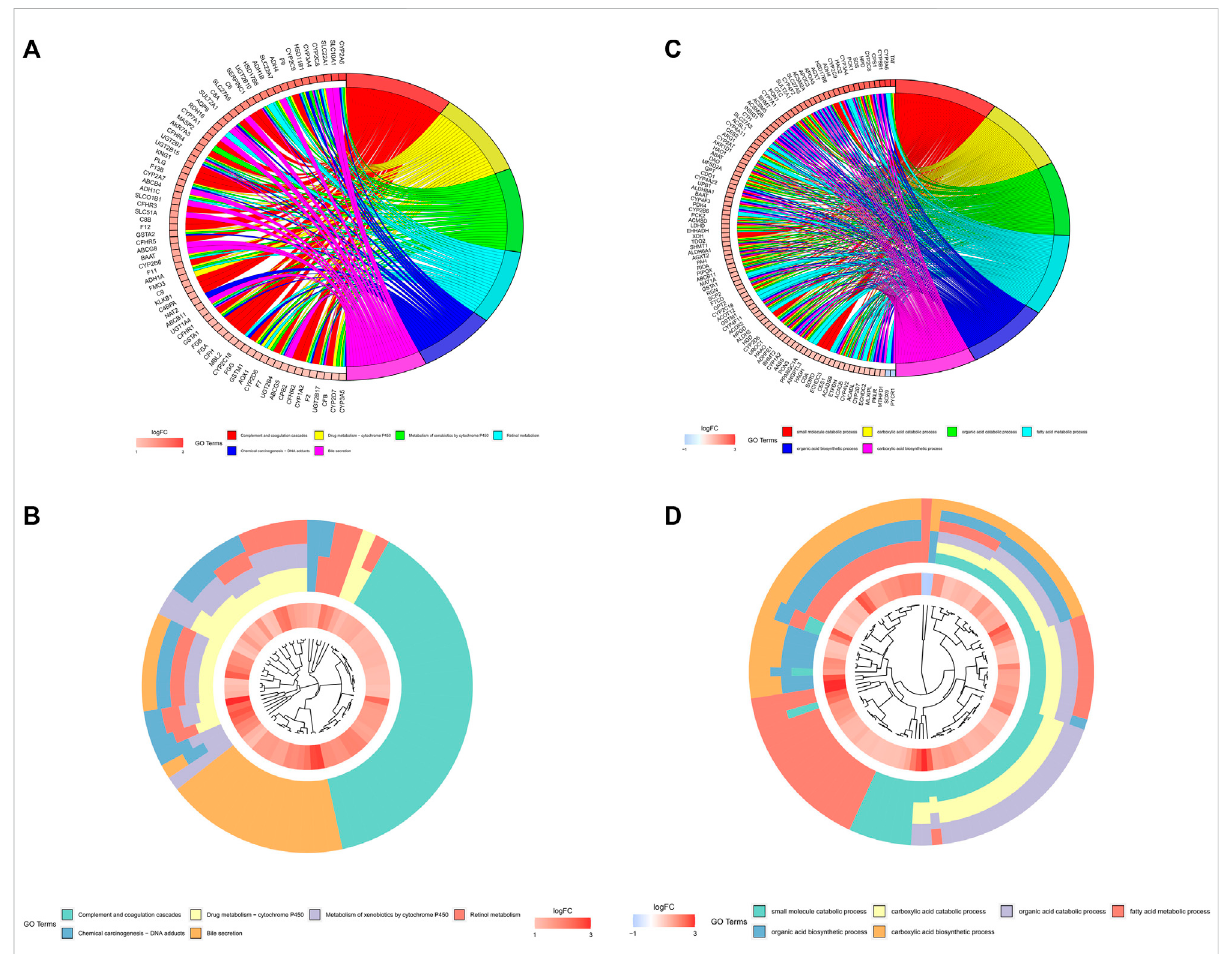
FIGURE 4 Analyses of the differentially expressed genes between the two clusters by the Kyoto Encyclopedia of Genes and Genomes (KEEG) and Gene Ontology (GO). The highly expressed genes in cluster one were functionally annotated applying the GO terms (A,B) and KEGG pathway (C,D)